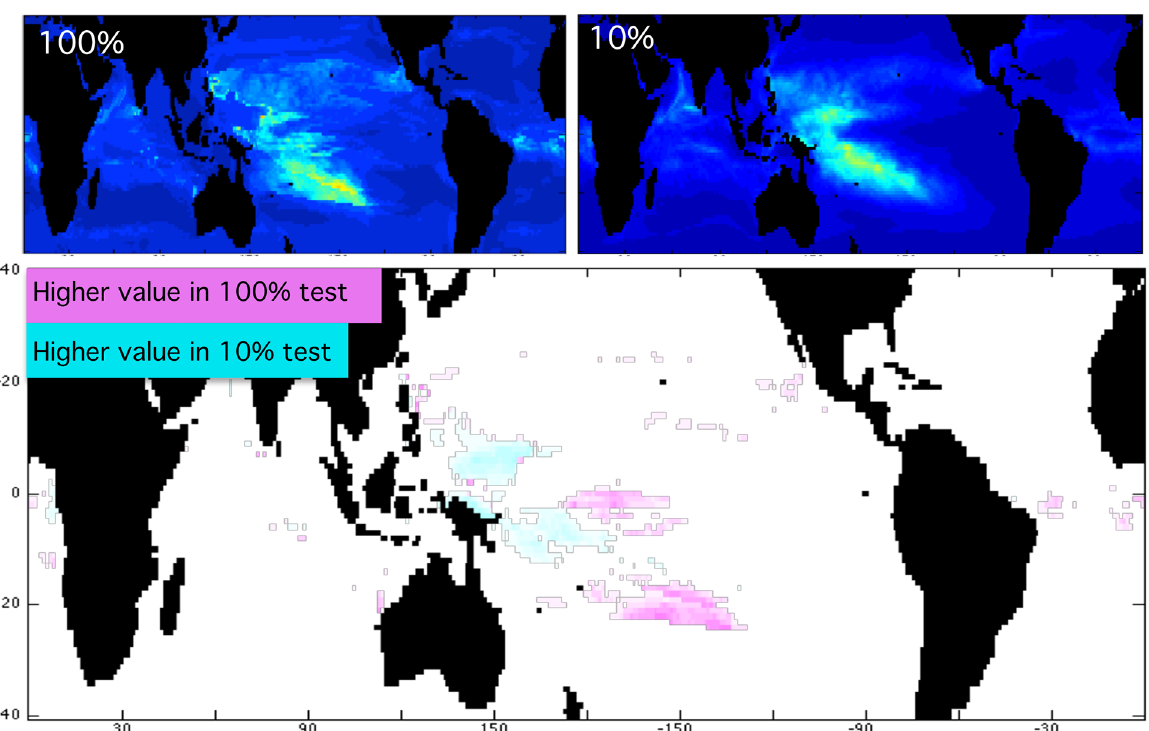
Fig 6. Comparison of Habitable Space From Tests Using All and Only 10% of Remote Pacific Reef Locations. A direct comparison of habitable space projections using 100% (top left) and 10% (top right) of the remote Pacific reef locations for training Maxent and subsequent calculations is shown in the maps above. Color scale is identical to Figs 3 – 4 and indicates habitat suitability from most (red) to least suitable (dark blue). Note the similarity in over- arching pattern of both maps above. The numerical difference between the maps is shown below. Differences < 0.1 are white. Higher values in the 100% test are shown in pink (darker hues for larger values), and higher values in the 10% test are shown in blue (darker hues for larger